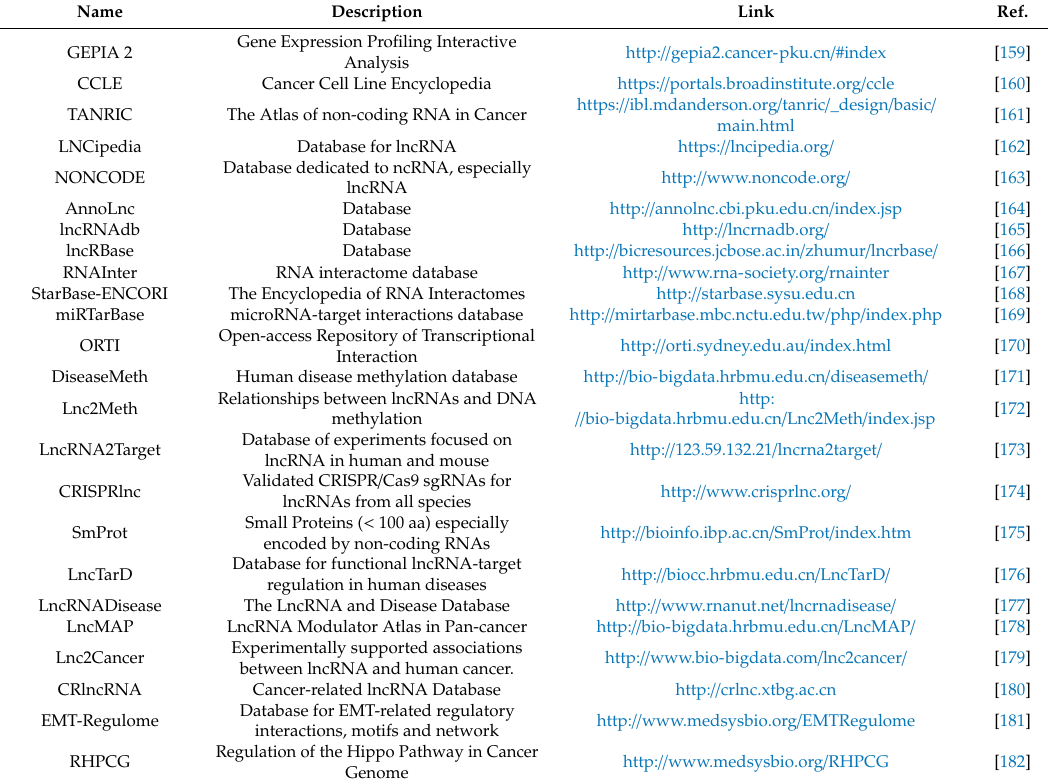
Table 6. Online databases containing useful information for the study of lncRNAs in ovarian